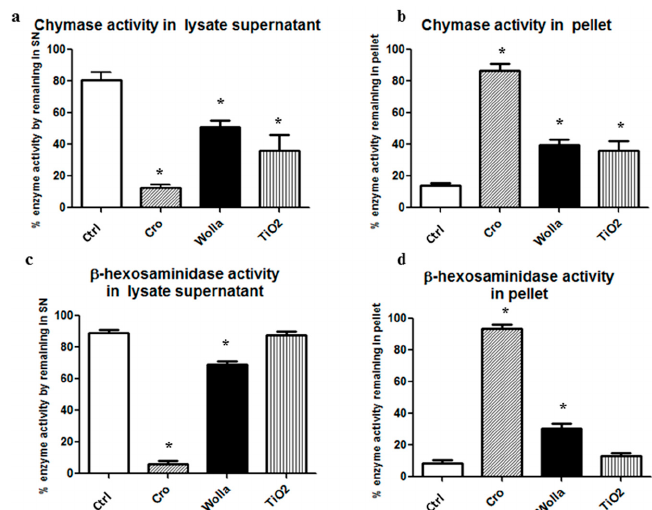
Figure 8 . Extent of RPMC lysate enzyme absorption on mineral fibers. After 30 min incubation of the lysate in the presence of fibers (100 μ g/mL), the supernatant was obtained by centrifuging the mixture at 250× g for 15 min at 4 °C. ( a , b ) fractionation of chymase activity; ( c , d ) fractionation of β -hexosaminidase activity. Significant changes in activity in the samples exposed to mineral fibers vs. baseline value (see the legend to Figure 7) are indicated by asterisks ( p < 0.05). CTRL = control unstimulated cells; Cro = crocidolite-exposed enzyme; Wolla = wollastonite-exposed enzyme; TiO 2 = TiO 2 NW-exposed enzyme.